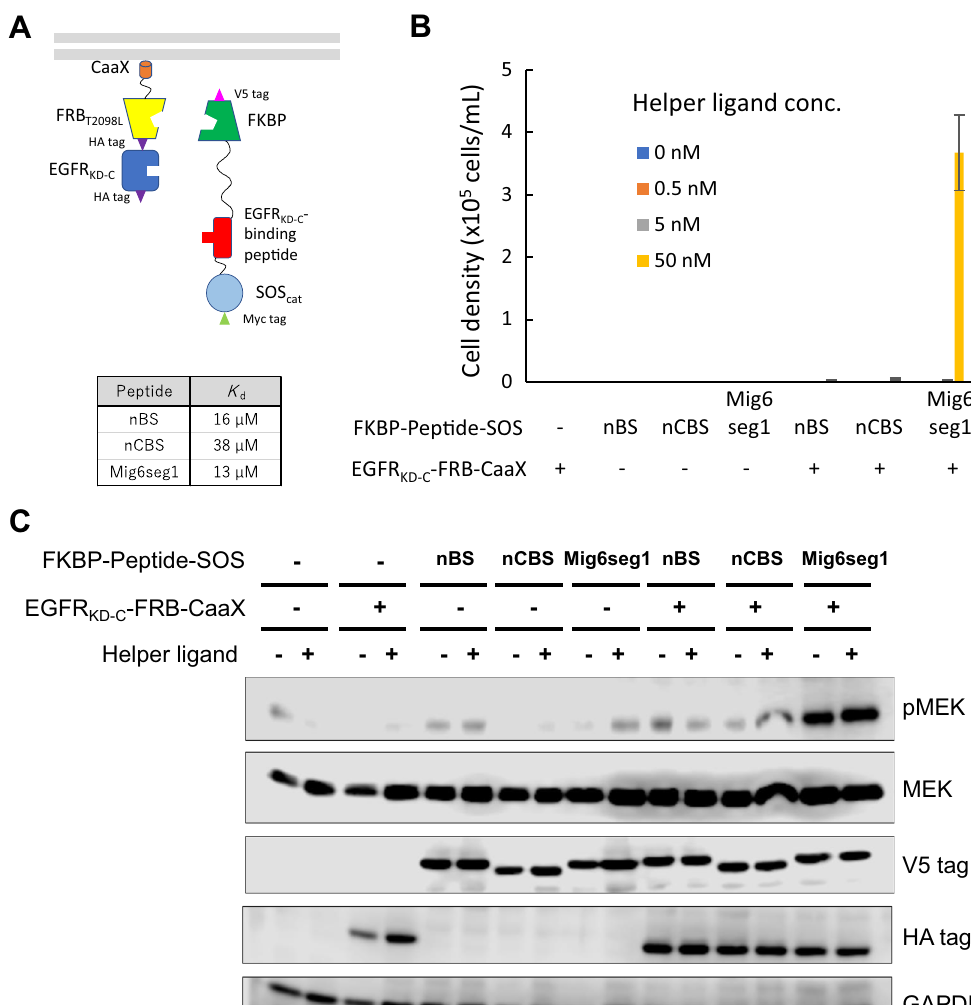
Figure 4. Detecting interactions between EGFR KD-C and its binding peptides by H-SOLIS. ( A ) The design of the membrane-anchored and signaling chimeras incorporating EGFR KD-C and its binding peptides. The dissociation constants of each peptide binding to EGFR KD-C are also shown. ( B ) Cell growth assay. Cells were seeded at 1 × 10 5 cells/mL and cultured for 3 days in the medium with the indicated concentrations of the helper ligand AP21967. Viable cell densities are shown as mean ± SD (n = 3, biological replicates). ( C ) Signaling analysis. Cells were stimulated for 15 min with or without 50 nM of the helper ligand AP21967. Phospho-MEK, whole MEK, V5 tag (FKBP-Peptide-SOS expression), HA tag (EGFR KD-C -FRB-CaaX expression), and GAPDH (loading control) were detected using corresponding primary antibodies. Uncropped blot images are provided in Supplementary Fig.